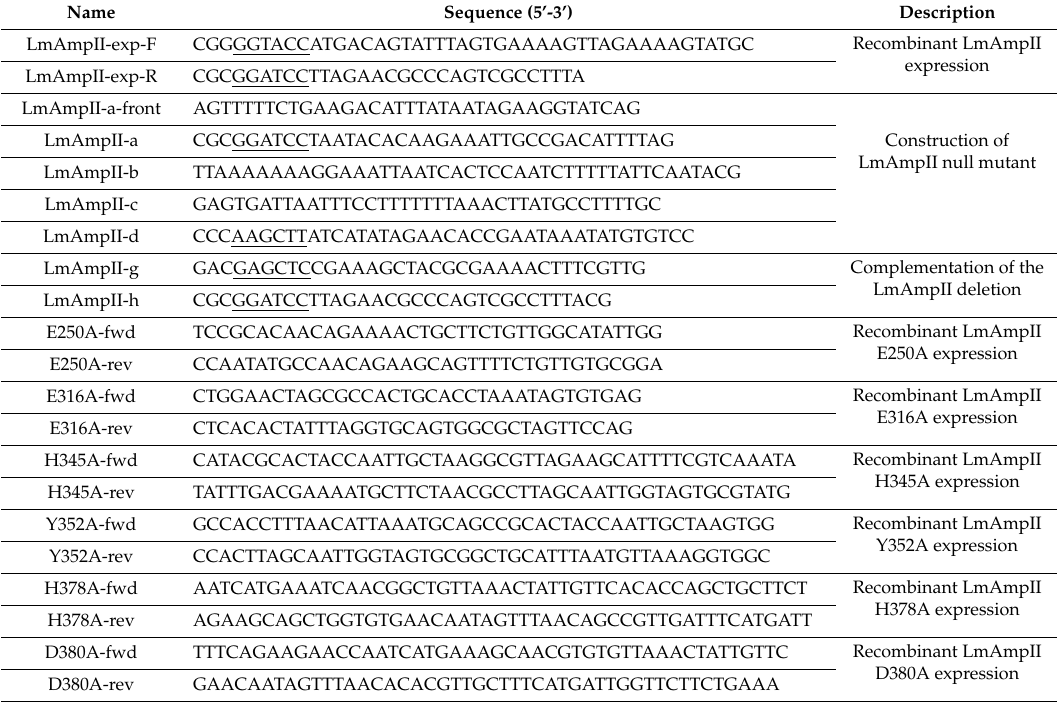
Table 1. PCR Primers used in this study. Nucleotides introduced to create restriction enzyme sites are